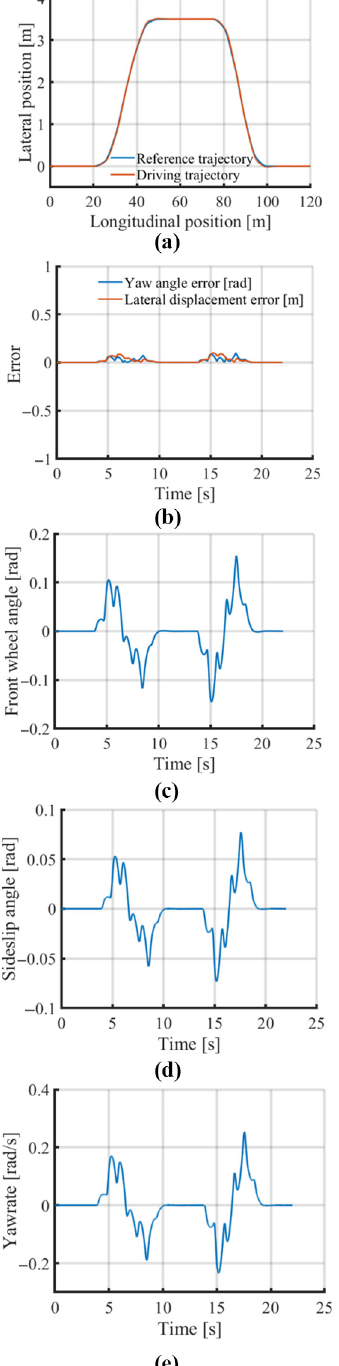
Figure 5 The simulation results. (a) Vehicle trajectory. (b) The error. (c) Front-wheel angle. (d) Sideslip angle. (e) Yaw rate